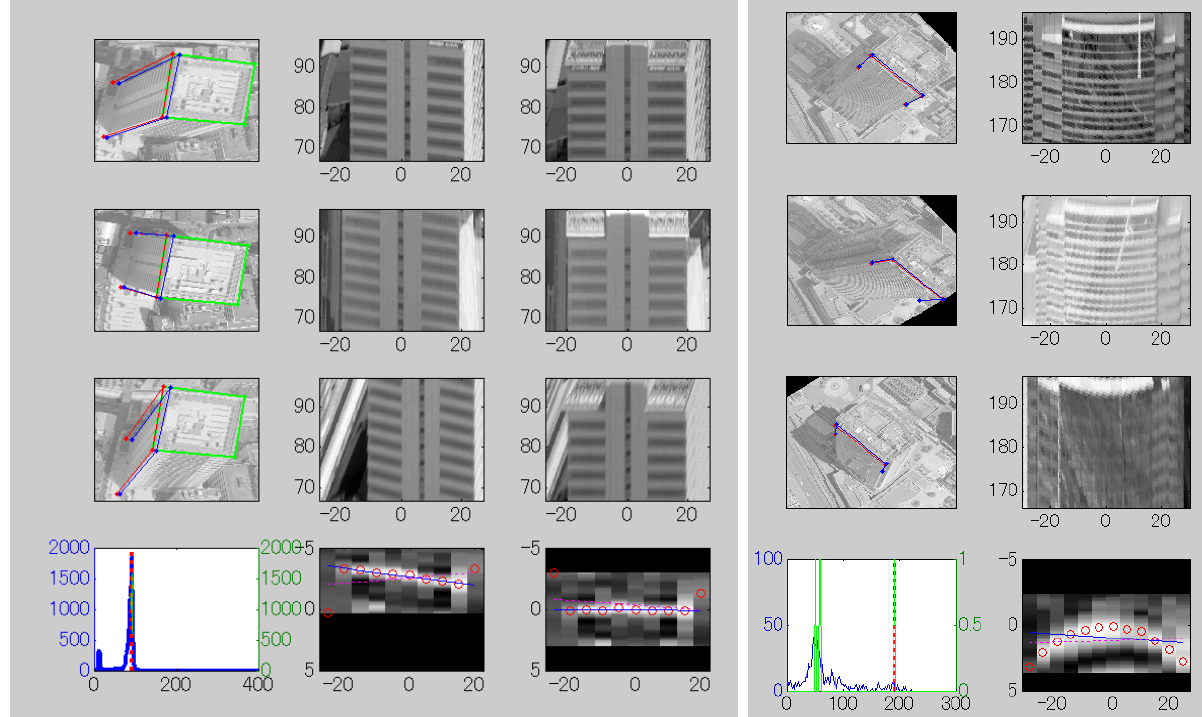
Figure 9. Result of Wall Matching (Left: Example of Direction Compensation / Right: Arch Wall)